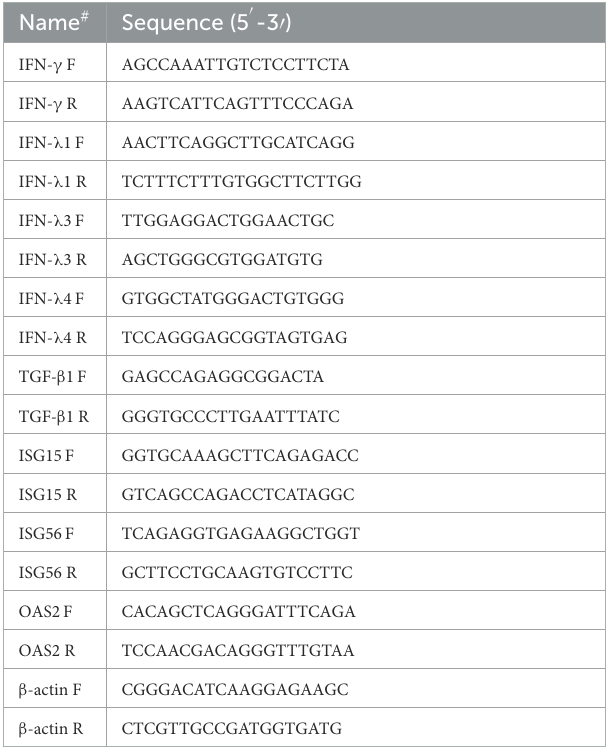
TABLE 1 Primers used for the relative quantitative